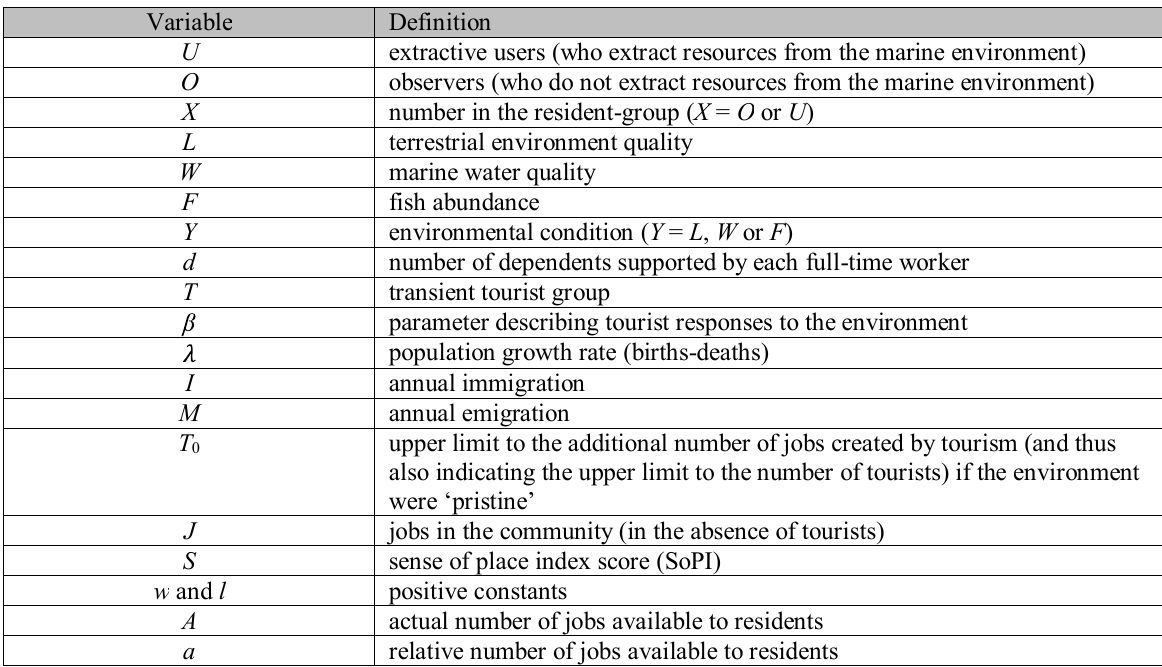
Table A1.1: Variables used to model a socio-ecological system of a small coastal